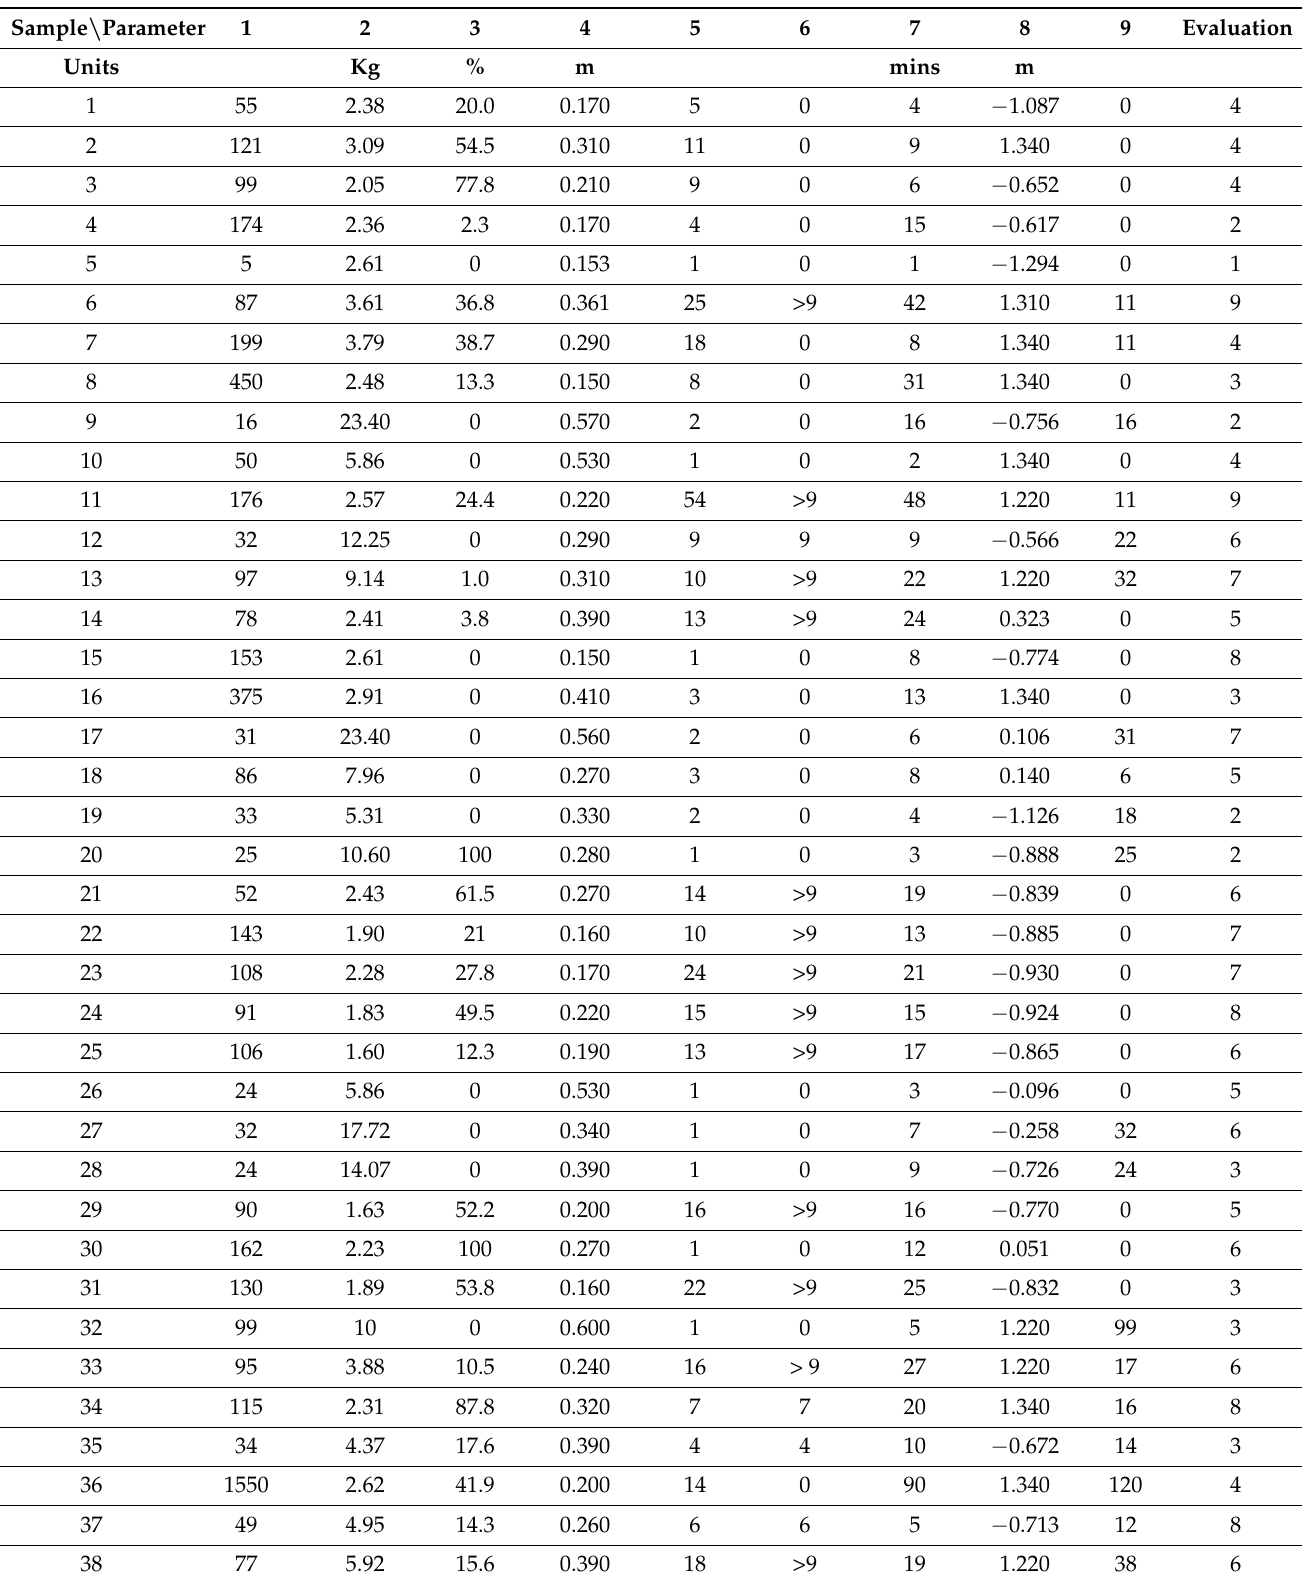
Table A1. Application of the created metrics in the collected set of